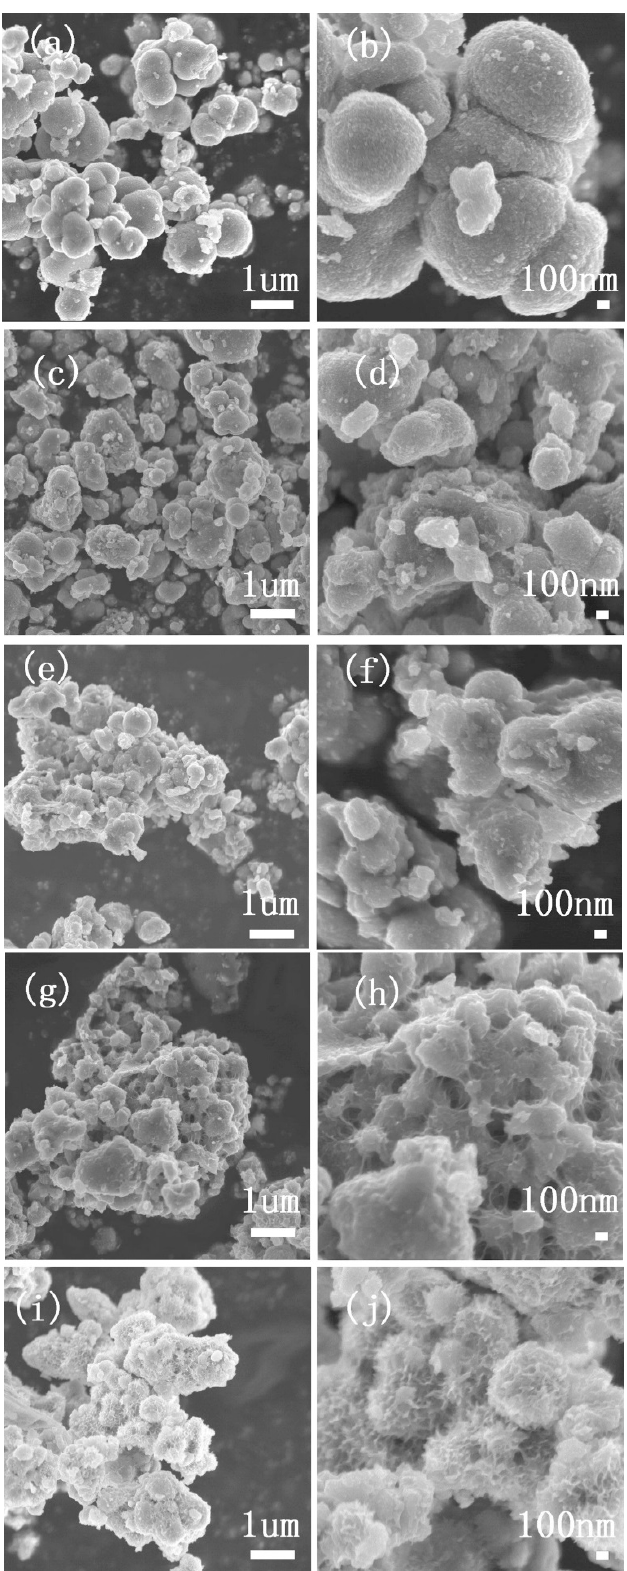
Figure 4. SEM images of the as-prepared samples: ( a , b ) 0 M; ( c , d ) 2 M; ( e , f ) 5 M; ( g , h ) 10 M; ( i , j ) 15 M.